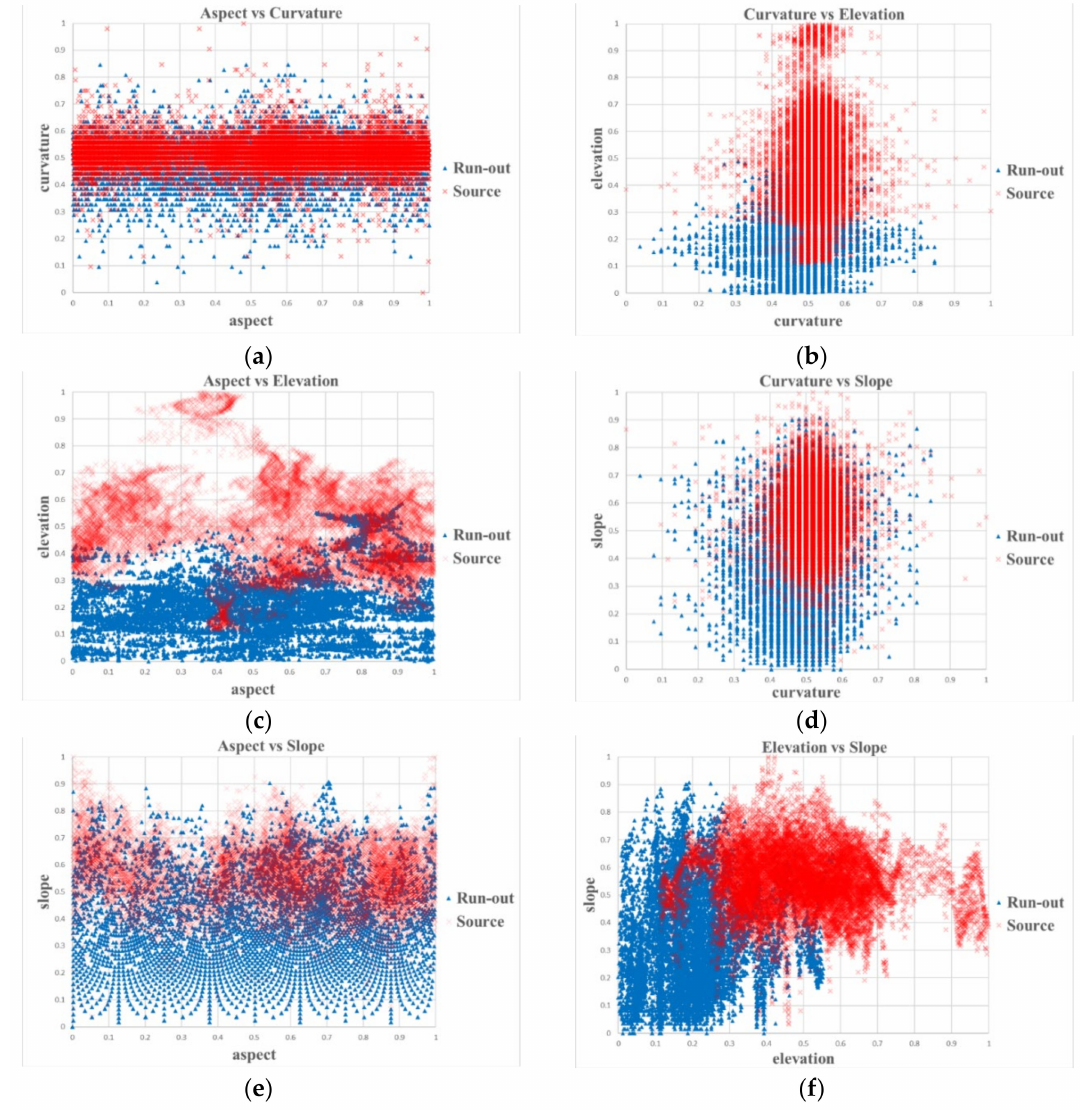
Figure 5. Patterns for comparing aspect, curvature, elevation, and slope layers with the samples extracted from the inventory polygon with an area of 50,000–100,000 m 2 , where red and blue dots represent the landslide source and runout classes, respectively. ( a ): Aspect vs. curvature.; ( b ): curvature vs. elevation; ( c ): aspect vs. elevation; ( d ): curvature vs. slope; ( e ): aspect vs. slope; ( f ): elevation vs.